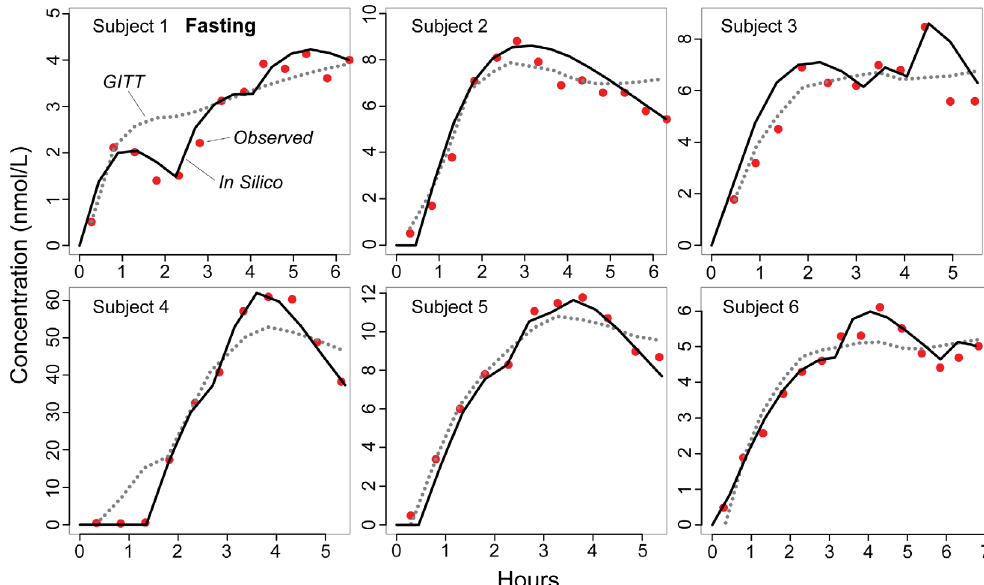
Figure 3. Drug plasma concentration vs. time profiles of individual subjects under fasting conditions. We used the analog from Fig. 2. To simulate a subject undergoing study, we started with default parameter values to initialize the analog and execute simulation. Analog plasma concentration was recorded each time step and compared with the referent profile at the end of simulation. If the outcome failed to validate, i.e., satisfy a prespecified level of similarity, we adjusted parameter values and repeated simulation. We repeated the process until the similarity was achieved. The analog parameterized to Table 2 values produced individual outcomes (black lines) that validated against the corresponding referent profiles. For comparison, the GITT model’s predicted concentrations (dotted curves) are reproduced from [17]. Observed concentrations (red) are from [8].